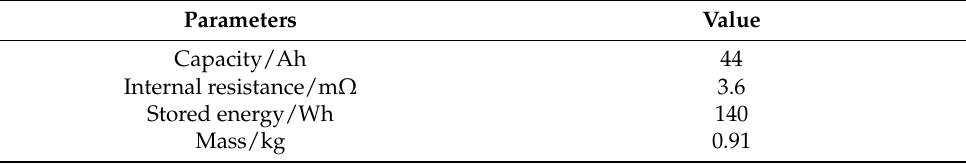
Table 2. SAFT VL45E Li-ion BT parameters.